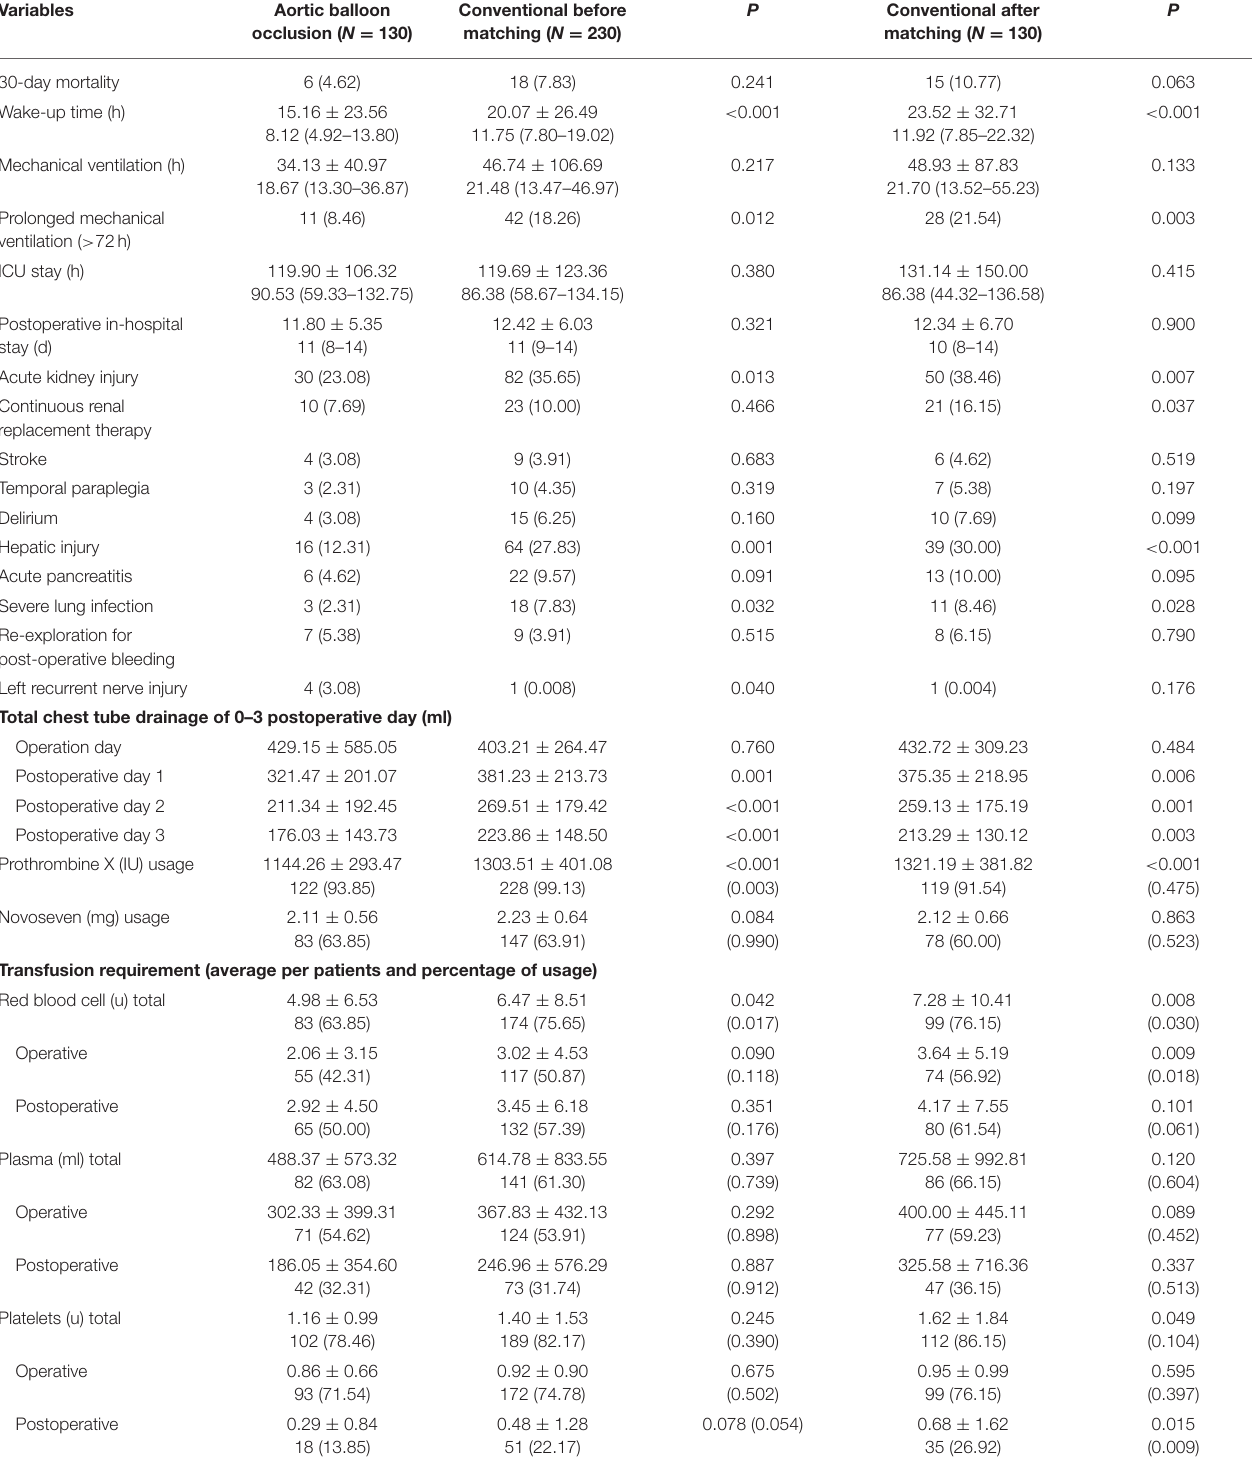
TABLE 2 | The early